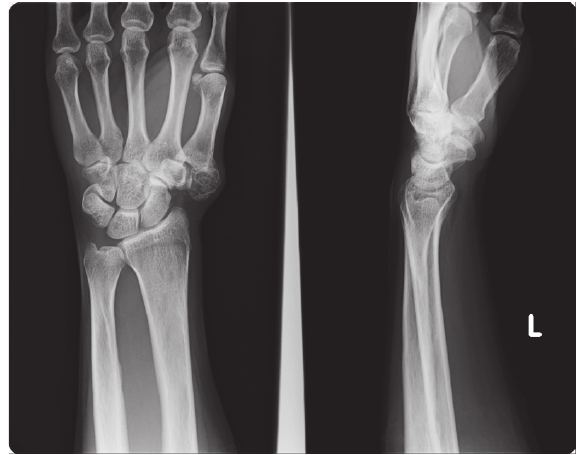
Figure 2: PA and lateral plain X-ray of the left hand showing a soft tissue lesion with calcifications adjacent to trapezium and the base of the first metacarpal bone.